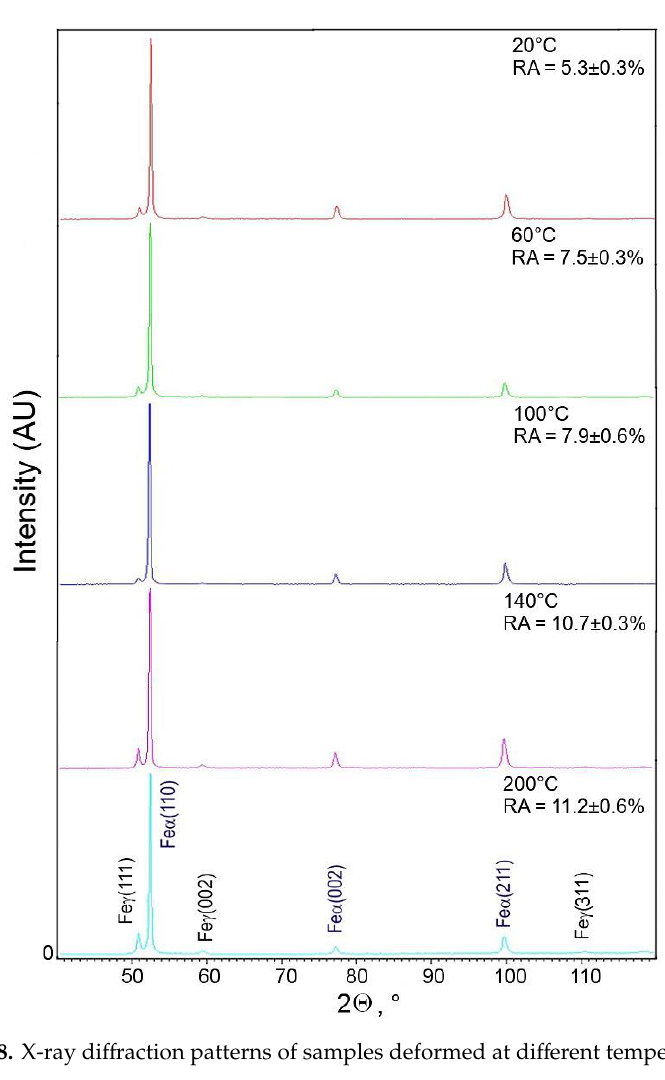
Figure 8. X-ray diffraction patterns of samples deformed at different temperatures.